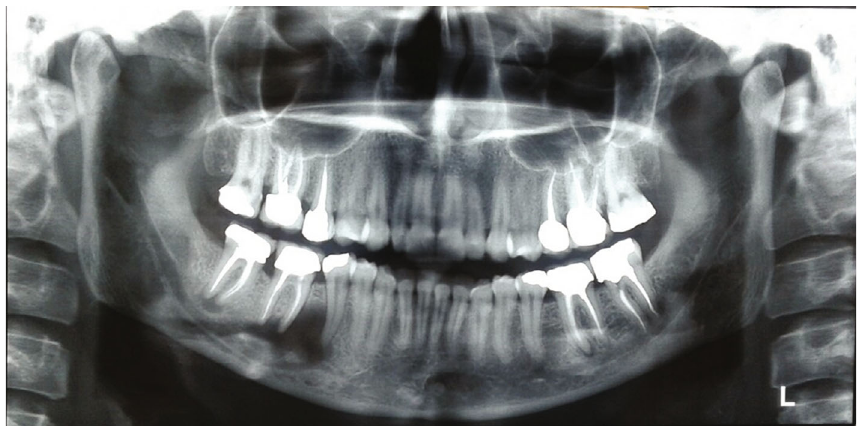
Figure 1: Initial OPG of the patient depicting a unilocular radiolucency encompassing the apices of the mandibular second premolar and fi rst molar.